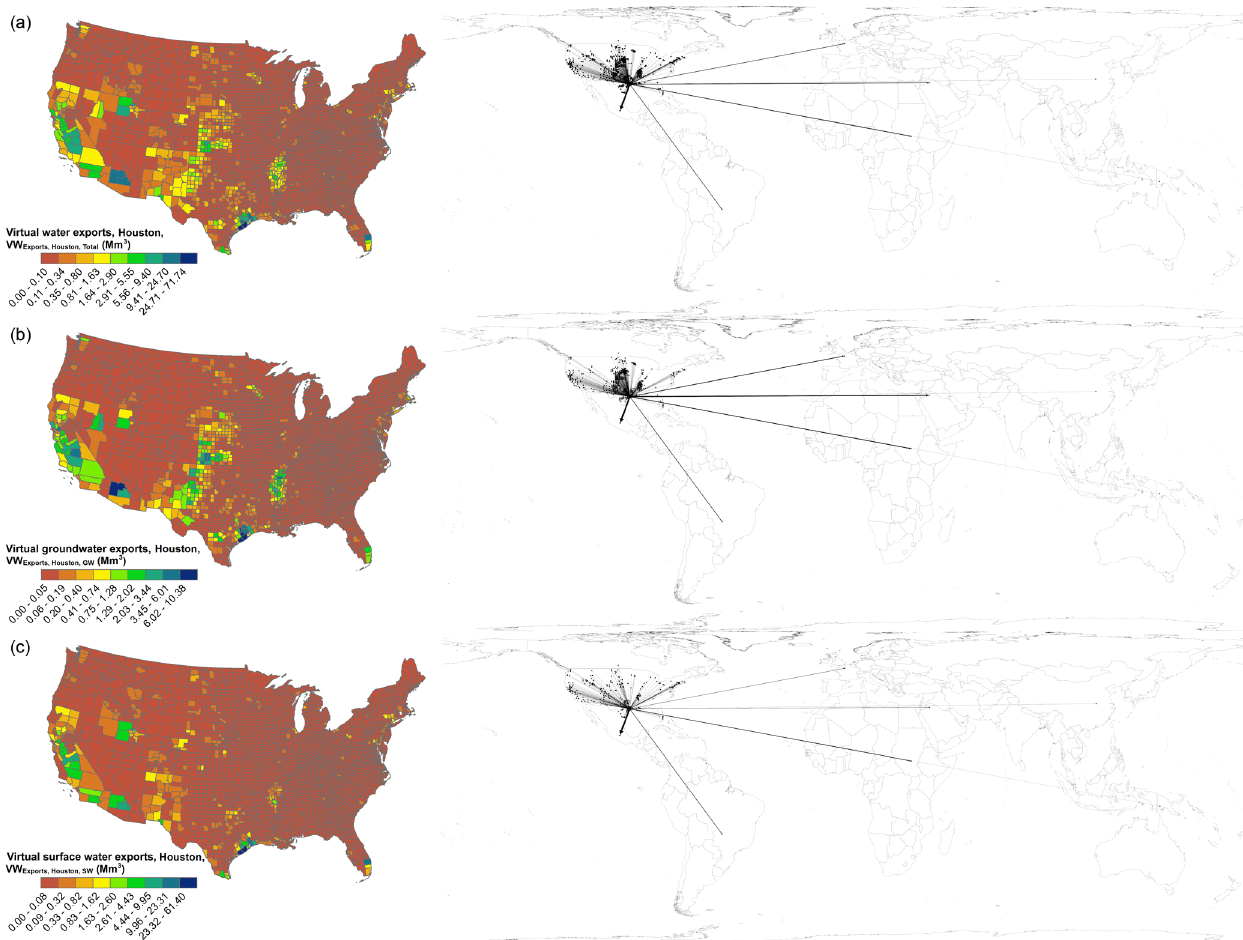
Figure 4. (a) US blue virtual water exports (CU Med ) through ports in the Houston metropolitan area are sourced from the Central Valley of California, central Utah and northern Utah, southern Arizona, the Ogallala Aquifer region, southern Texas and the Texas Gulf Coast, and the Mississippi Embayment aquifer region. Virtual water flows into the Houston ports and then is redistributed to the eight world regions in NWED. Mexico is the largest recipient of virtual water flows from Houston ports. (b) Virtual groundwater flow-through Houston ports is sourced from the Central Valley of California, central Utah and northern Utah, southern Arizona, the Ogallala Aquifer region, southern Texas and the Texas Gulf Coast, and the Mississippi Embayment aquifer region. (c) Virtual surface water through Houston ports is sourced from the Central Valley of California, southern California, the Phoenix metropolitan area, northern Utah, and the Texas Gulf Coast. Network maps are plotted with Gephi using the Map of Countries and GeoLayout